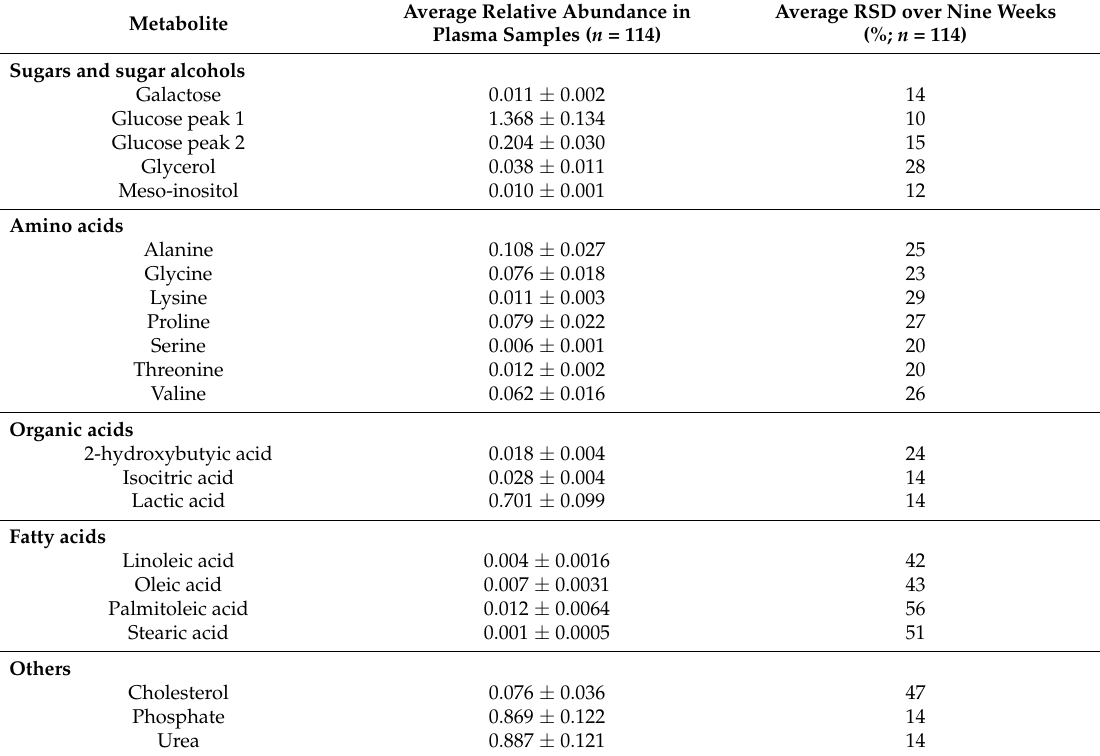
Table 3. Major metabolites present in plasma samples and their Residual Standard Deviation (RSD) over nine